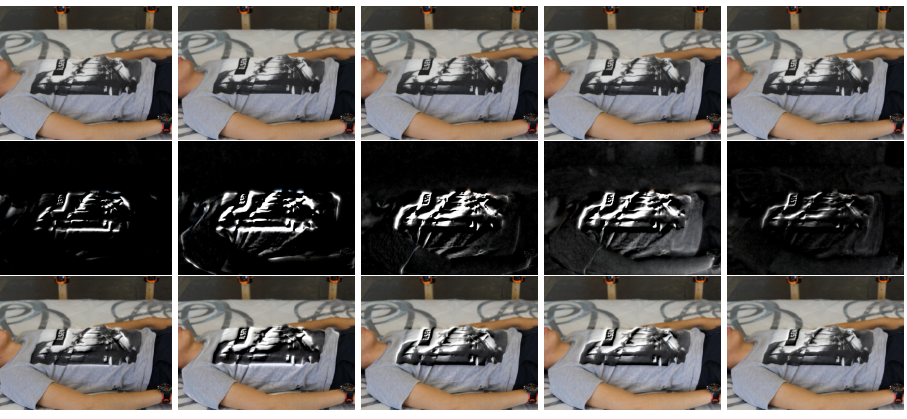
Figure 6. Several input frames (first row). Reconstructed and magnified frames using the inverse Hermite transform (second row). RGB frames’ results of the motion magnification process (third